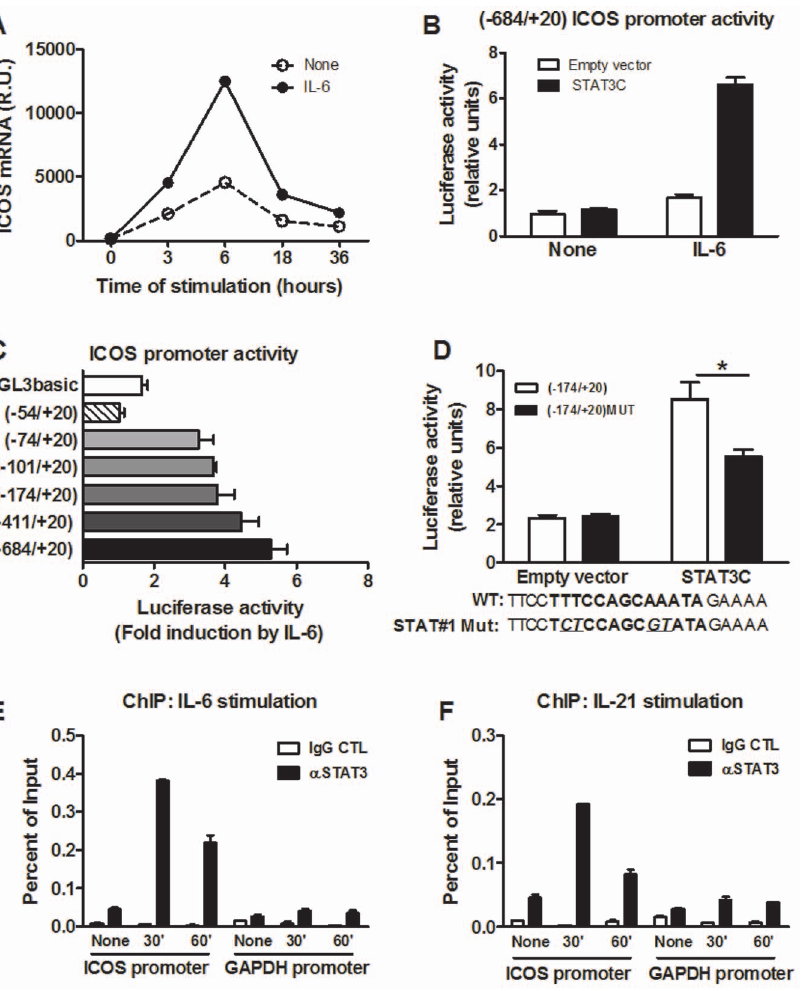
Figure 5. STAT3 promotes ICOS transcription through direct interaction with the STAT # 1 binding site. A) Naive cord blood CD4 T cells were stimulated with anti-CD3 and anti-CD28 mAbs in the presence or absence of rIL-6 before measuring ICOS mRNA expression by qRT-PCR. Data are one representative out of 3 experiments on different donors. B) EL4 cells were co-transfected with the ( 2 684/ + 20) ICOS reporter construct containing a luciferase element and STAT3C or control plasmids. Data are mean 6 SEM of triplicates of one experiment out of 5 independent experiments. C) EL4 cells were co-transfected with the indicated reporter plasmid and STAT3C. Twenty-four hours after transfection, cells were incubated with rIL-6 or medium alone for an additional 24 hours before measuring luciferase activity. Data were normalized against unstimulated conditions for each construct and are mean 6 SEM of triplicates of 4 independent experiments. D) EL4 cells were co-transfected with the ( 2 174/ + 20) WT or mutated ICOS reporter construct and STAT3C. Cells were then incubated with rIL-6 or medium alone for an additional 24 hours before measuring luciferase activity. Data are mean 6 SEM of triplicates of 4 independent experiments. The sequences of the STAT # 1 binding site (nt 2 57/ 2 43) and the mutation introduced in ( 2 174/ + 20) MUT constructs are depicted. E and F) ChIP experiments. Naive cord blood CD4 T cells were stimulated with anti-CD3 mAb in the presence of rIL-6 or rIL-21. Chromatin samples were immunoprecipitated with anti-STAT3 or control antibodies. Purified DNA samples were subjected to qPCR amplification using primers encompassing the STAT # 1 site from the ICOS promoter or specific for the proximal GAPDH promoter region. Data are mean 6 SEM of triplicates of one representative out of two experiments on different donors. R.U.: relative